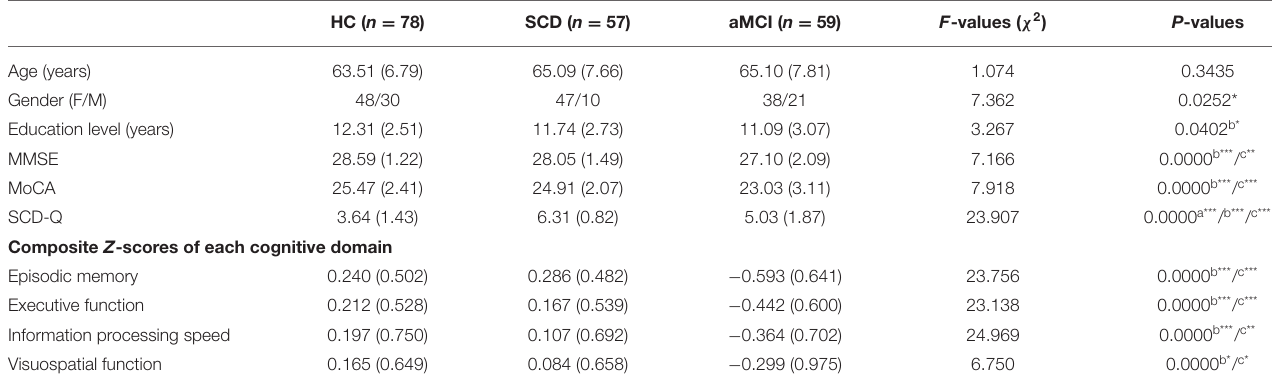
TABLE 1 | Demographics and clinical characteristics of HC, SCD, and aMCI